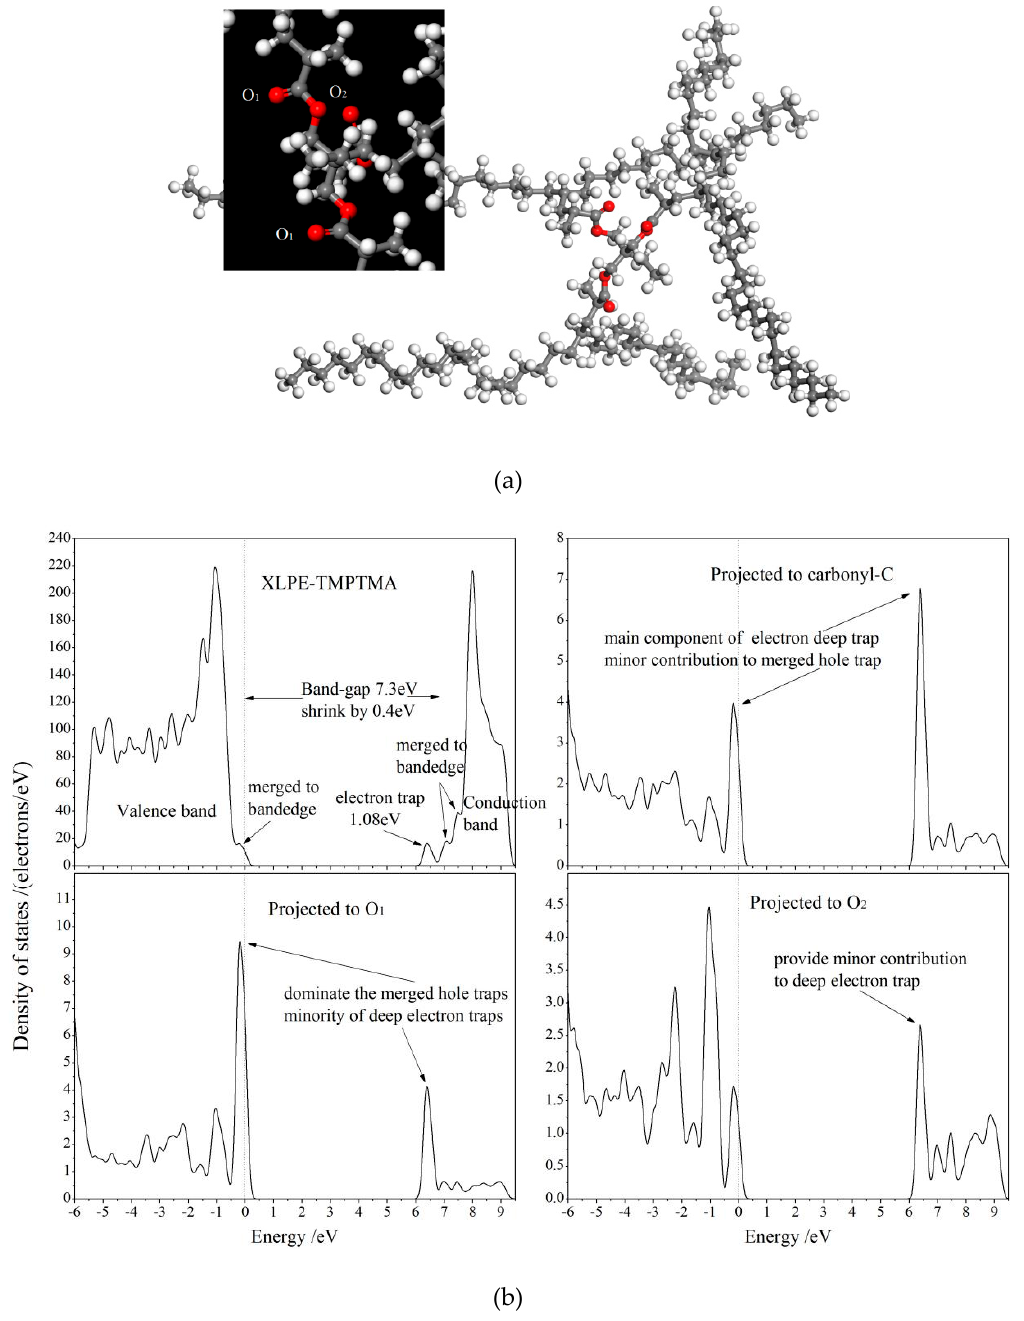
Figure 5. ( a ) Schematic molecular structure (inset magnifies TMPTMA crosslinker) and ( b ) total and atomic-projected density of states for XLPE-TMPTMA molecule in which the highest occupied molecular orbital is referenced as energetic zero being indicated by vertical dashed lines.